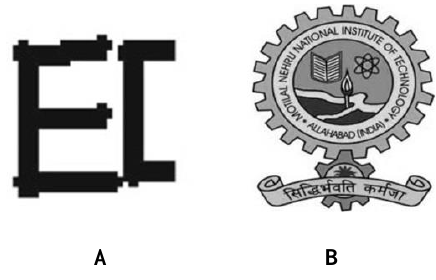
Figure 4: Image Watermarks used (A) EC Logo (B) MNNIT Logo.